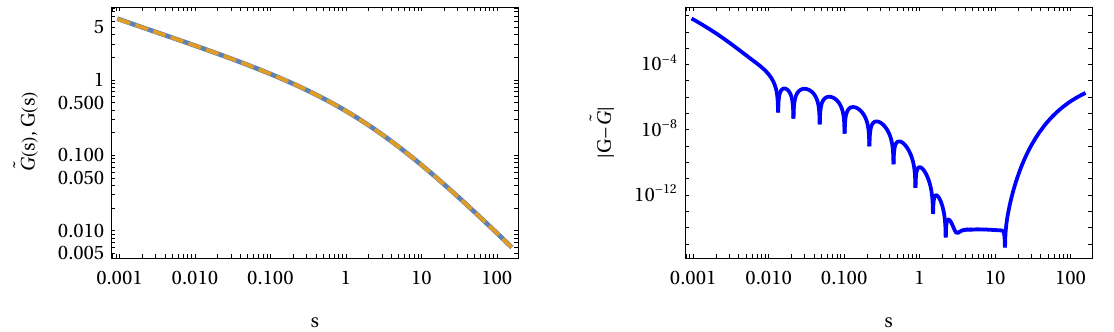
Figure 5. Approximation of the transfer function G ( s ) for a fractional relaxation Equation (88). The left panel shows the exact transfer function G ( s ) with χ 0 = 1, τ = 1, and α = 2/3 in connection with the approximation ˜ G ( s ) using Thiele’s algorithm. The right panel shows the local error between the exact function G ( s ) and its approximation. The total number of points used in the approximation is m = 2 N + 1 =